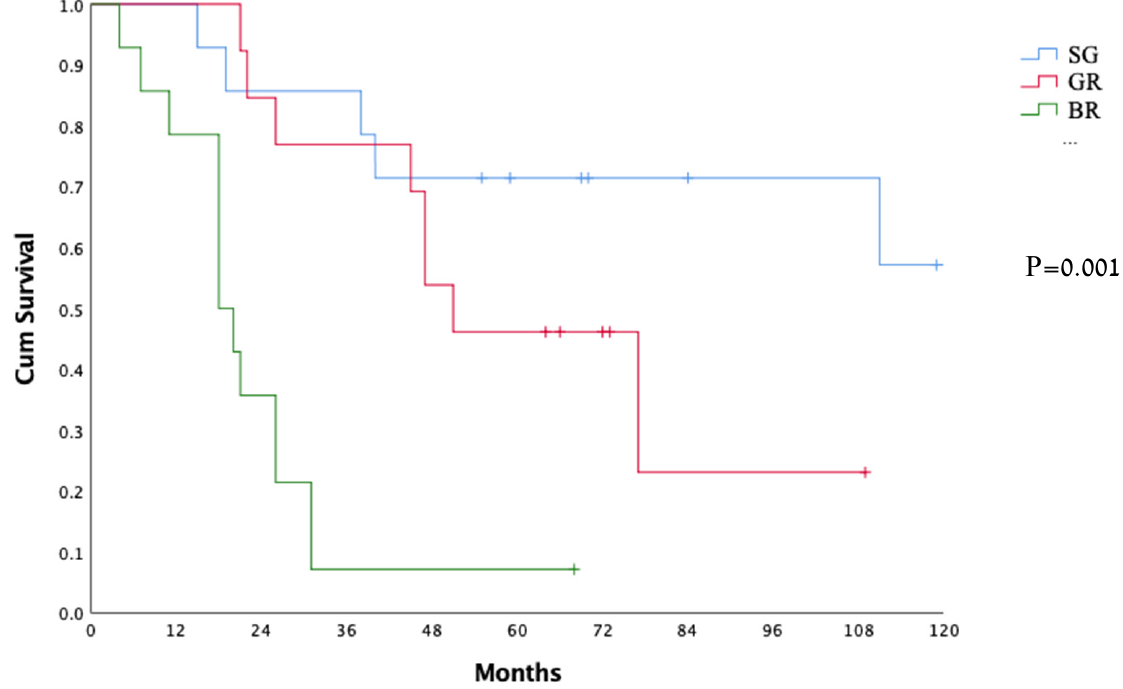
Figure 1. Kaplan–Meier curves of overall survival of all the cohort. SG—surgery group; GR—good responders; BR—bad responders.